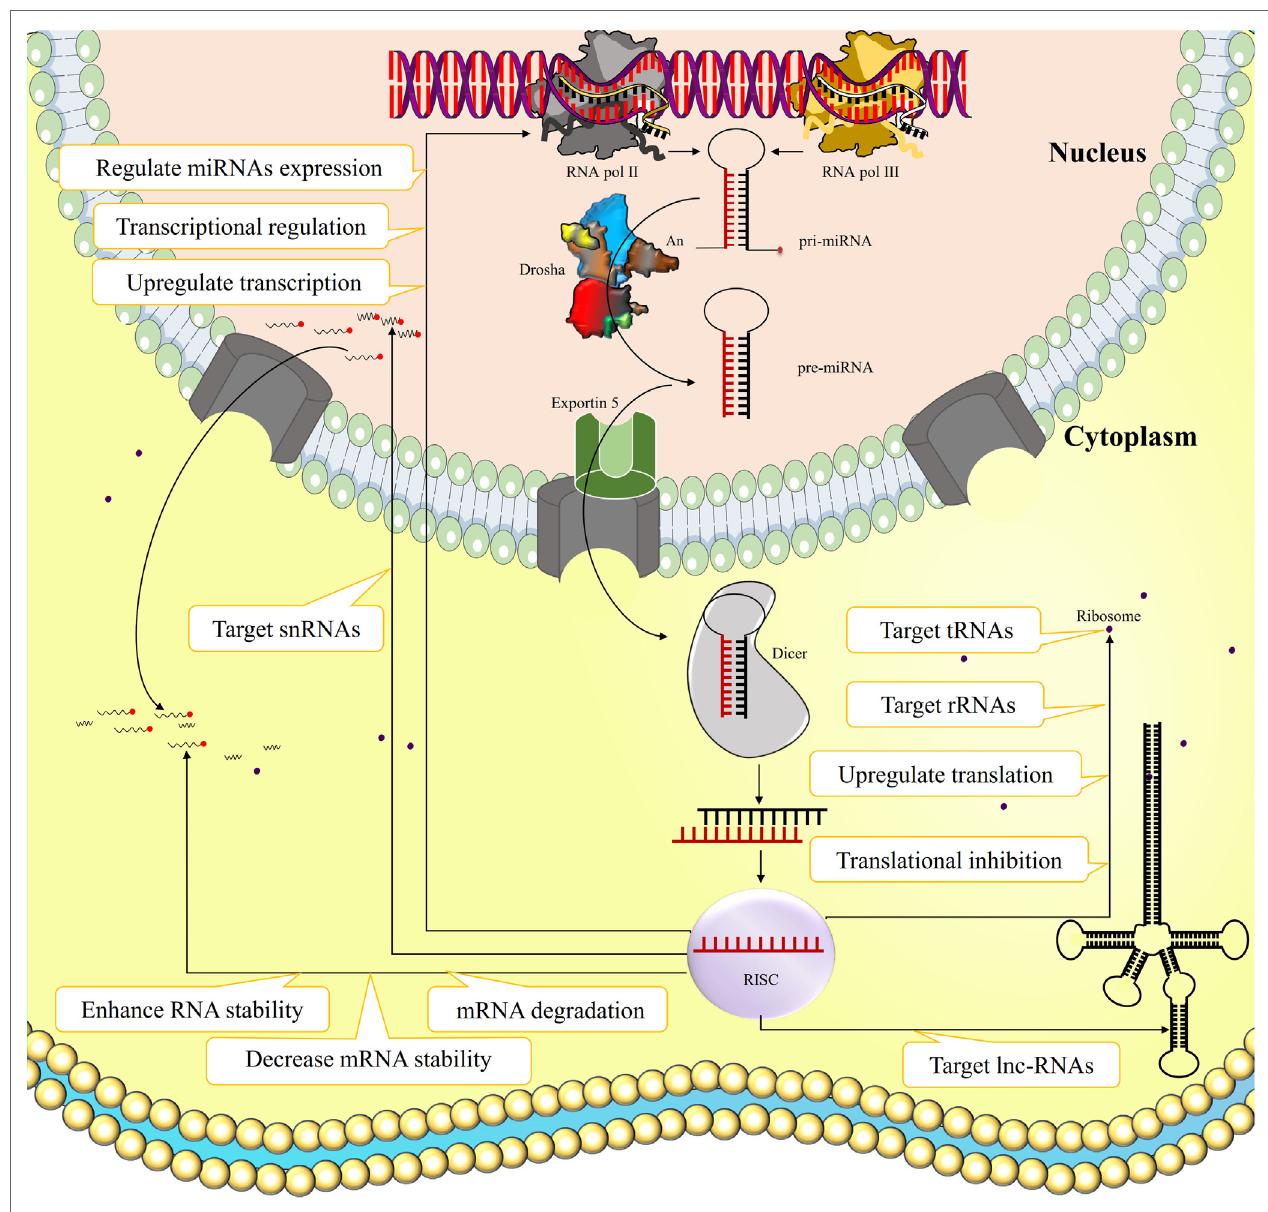
FigURe 1 | The biogenesis and function of microRNAs (miRNAs). miRNA is a short non-coding ribonucleic acid originated inter- or intragenicaly by RNA pol III and II, respectively. After initial processing by RNase Drosha in the nucleus, the pre-miRNA is transported to the cytoplasm where the miRNA hairpin is cleaved by endoribonuclease Dicer, forming an miRNA duplex. One of the miRNA strands loads into the RNA inducing silencing complex (RISC) that regulates mRNA transcription and protein translation through various ways. The miRNA binding to its target usually results in mRNA degradation, decreased mRNA stability, or translational inhibition, and hence they can influence transcriptional regulation of target genes. Alternatively miRNAs occasionally can enhance RNA stability and even upregulate transcription and translation of their certain targets. Some evidence also indicated that miRNAs can target long-non-coding RNAs (lncRNAs), ribosomal RNAs (rRNAs), transfer RNAs (tRNAs), and small nuclear RNAs (snRNAs), and regulate expression of other miRNAs.